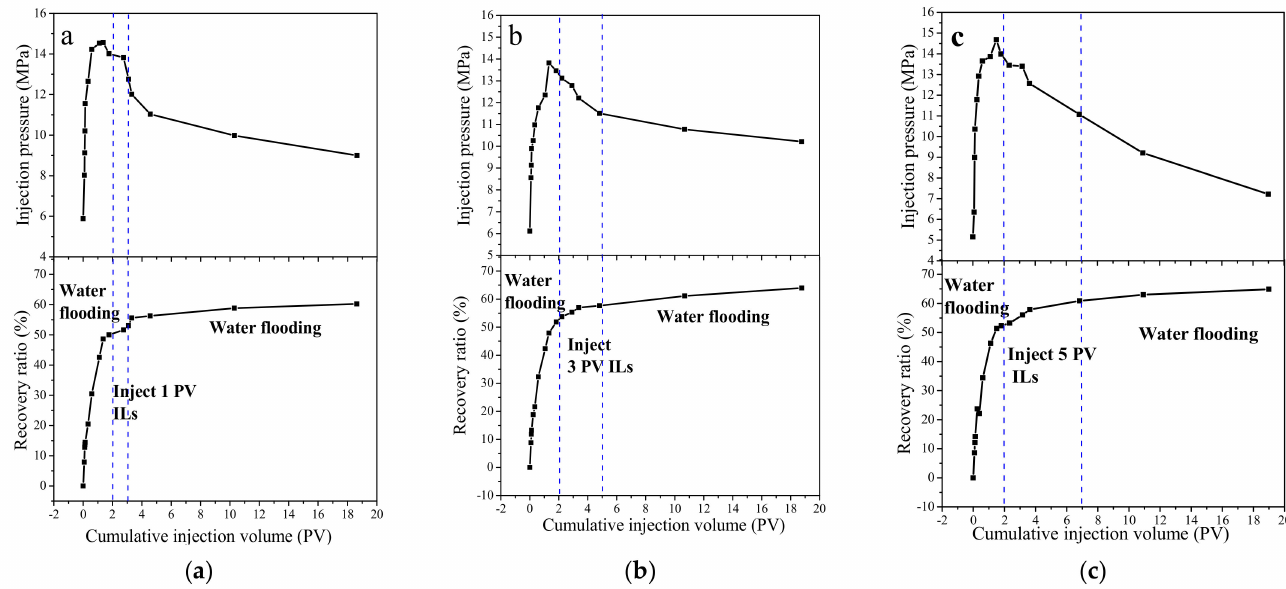
Figure 6. Injection volume curves and recovery ratio curves during oil displacement: ( a ) 1 PV; ( b ) 3 PV; ( c ) 5 PV of C 8 − OMImBF 4 ILs